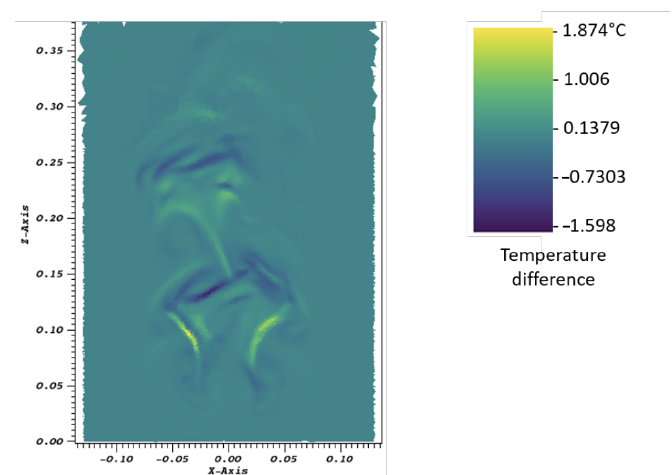
Figure 5. Temperature differences during 1